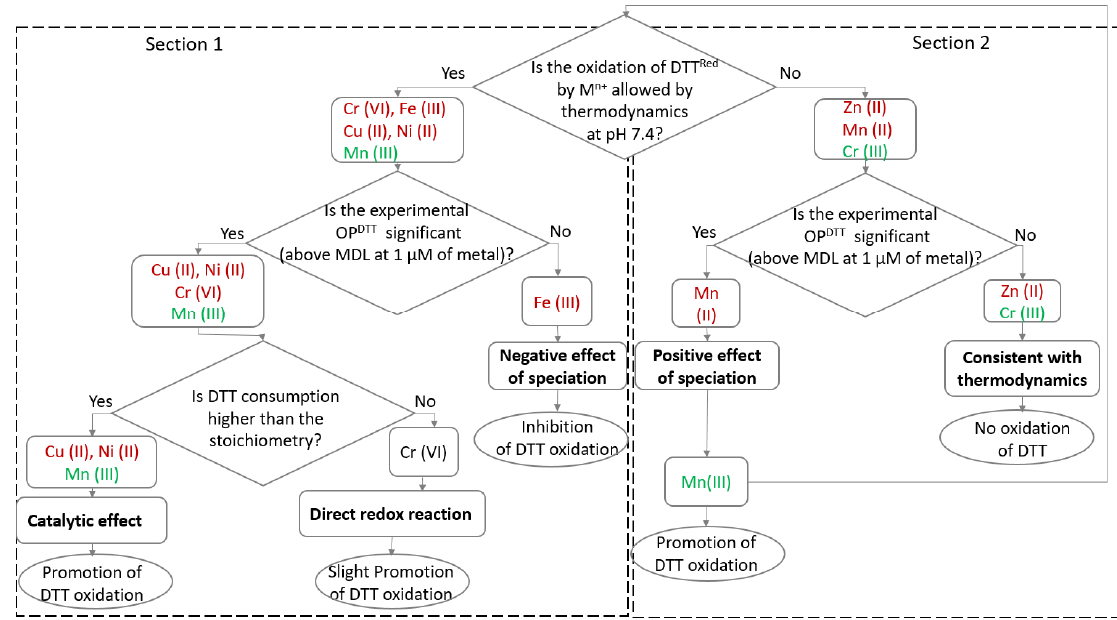
Figure 1. Flowchart of the suggested reactivity of transition metals with DTT: In red is the components initially present in the reactional media and in green is the components possibly resulting from a secondary reaction.